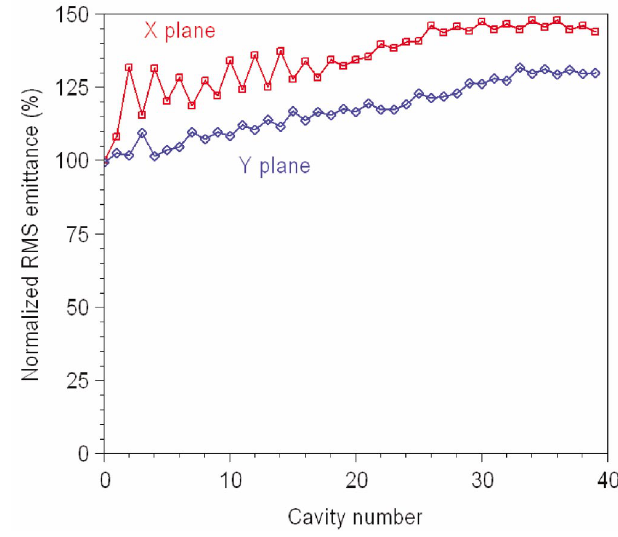
FIG. 29. (Color) rms emittance growth in percentages at 40 mA.